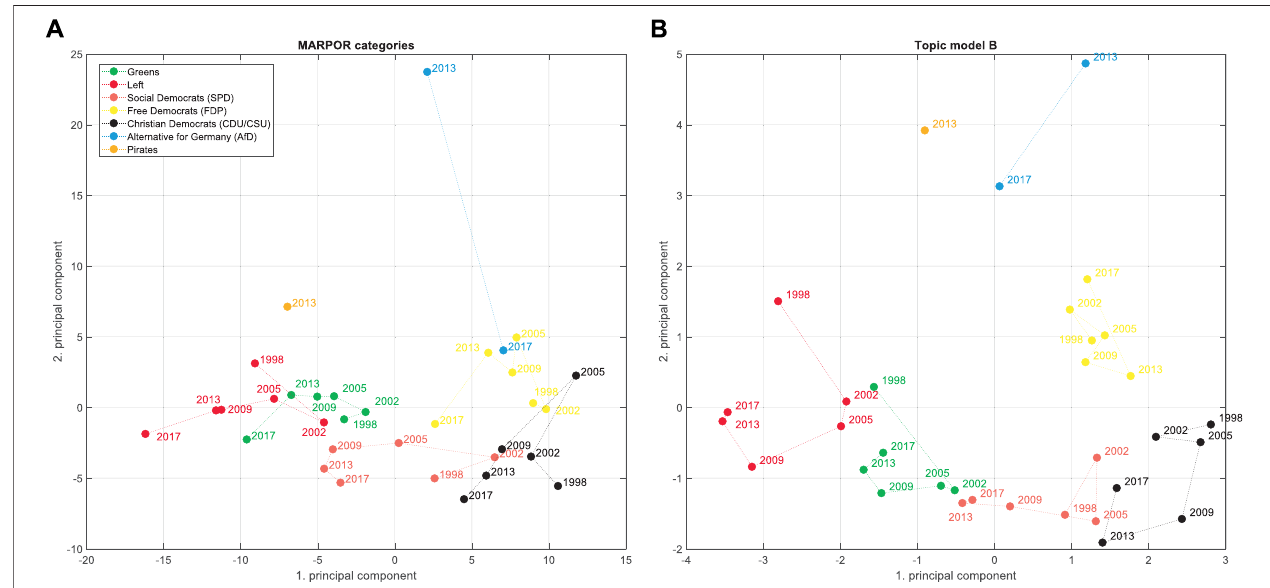
FIGURE 3 | Political spaces spanned by the fi rst and second PCA component from the MARPOR counts (A) and for the topic model B (B) for Germany 1998 – 2017.